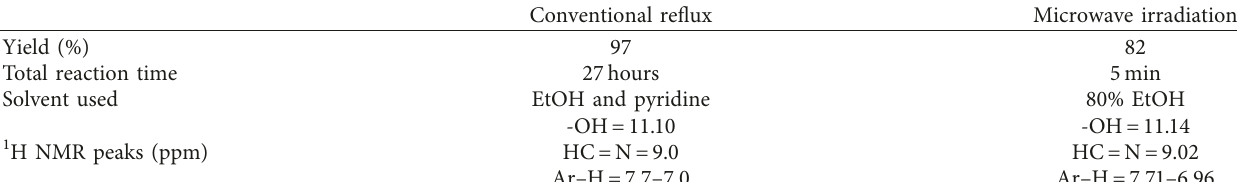
Table 1: Comparison between conventional reflux and microwave irradiation in synthesizing HLa.